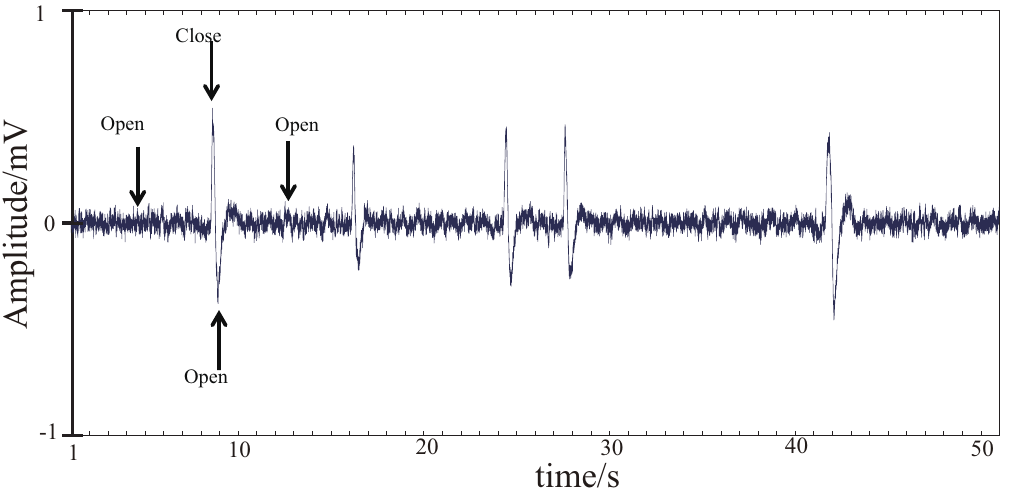
Figure 8. The characteristic waveform of the potential change caused by eye-blinking decomposed from measured EEG signals by ICA. By comparing with the video recorded during the experiments, the results show that the potential does not change substantially when the eyes open. At the time of eyes closed, a positive potential is generated, and when the eye opened again, a negative potential is generated. After the blink, the potential returns to 0 again.